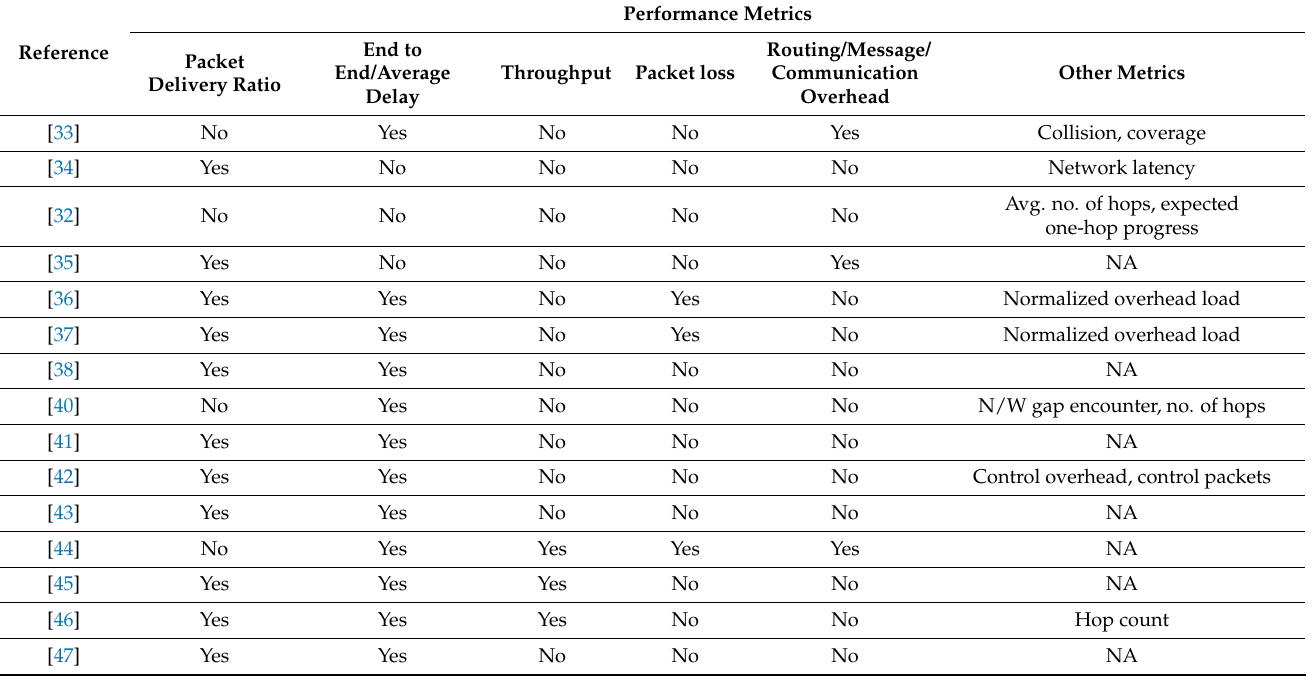
Table 10. Performance metrics of urban scenario with traffic signals/traffic based routing